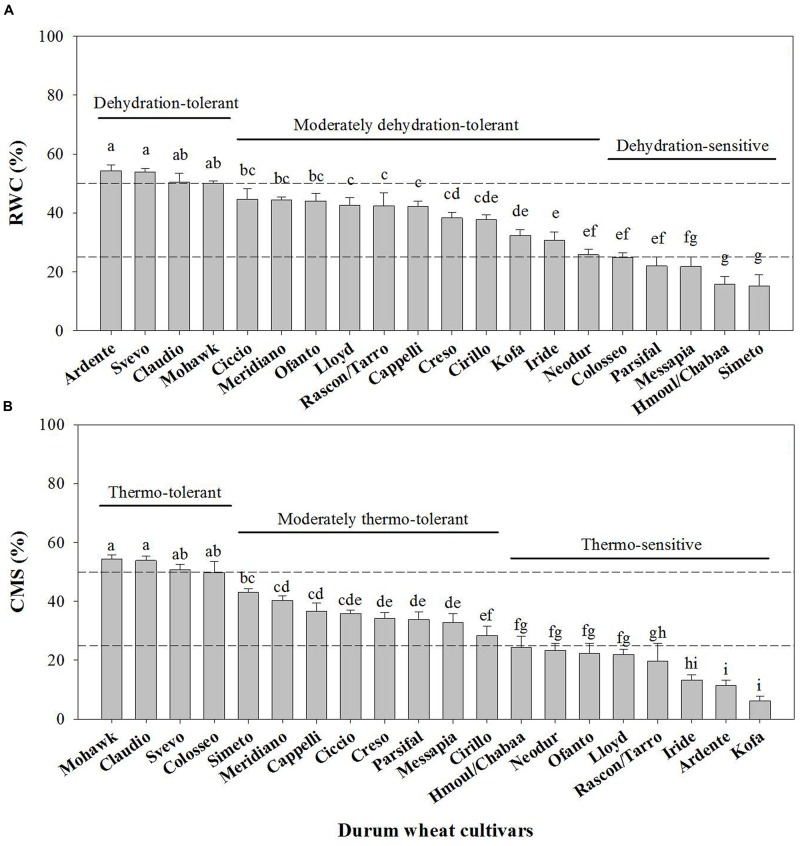
Relative Water Content (RWC) (A) and Cell Membrane Stability (CMS) (B) indices of T. durum Desf. cultivars. The reported RWC percentages refer to 10-day-old seedlings subjected to 24 h dehydration. RWCs of control plants (not shown) were not significantly different among the analyzed cultivars (RWC ∼98%). CMS indices were determined according to the method of Fokar et al. (1998) for basal thermo-tolerance assessment. Data are the mean ± standard deviation of three independent replicates (n = 3). Data were submitted to one-way analysis of variance (ANOVA), Different letters above bars indicate statistically significant differences among cultivars (p < 0.05), as determined by the Tukey’s post hoc test.